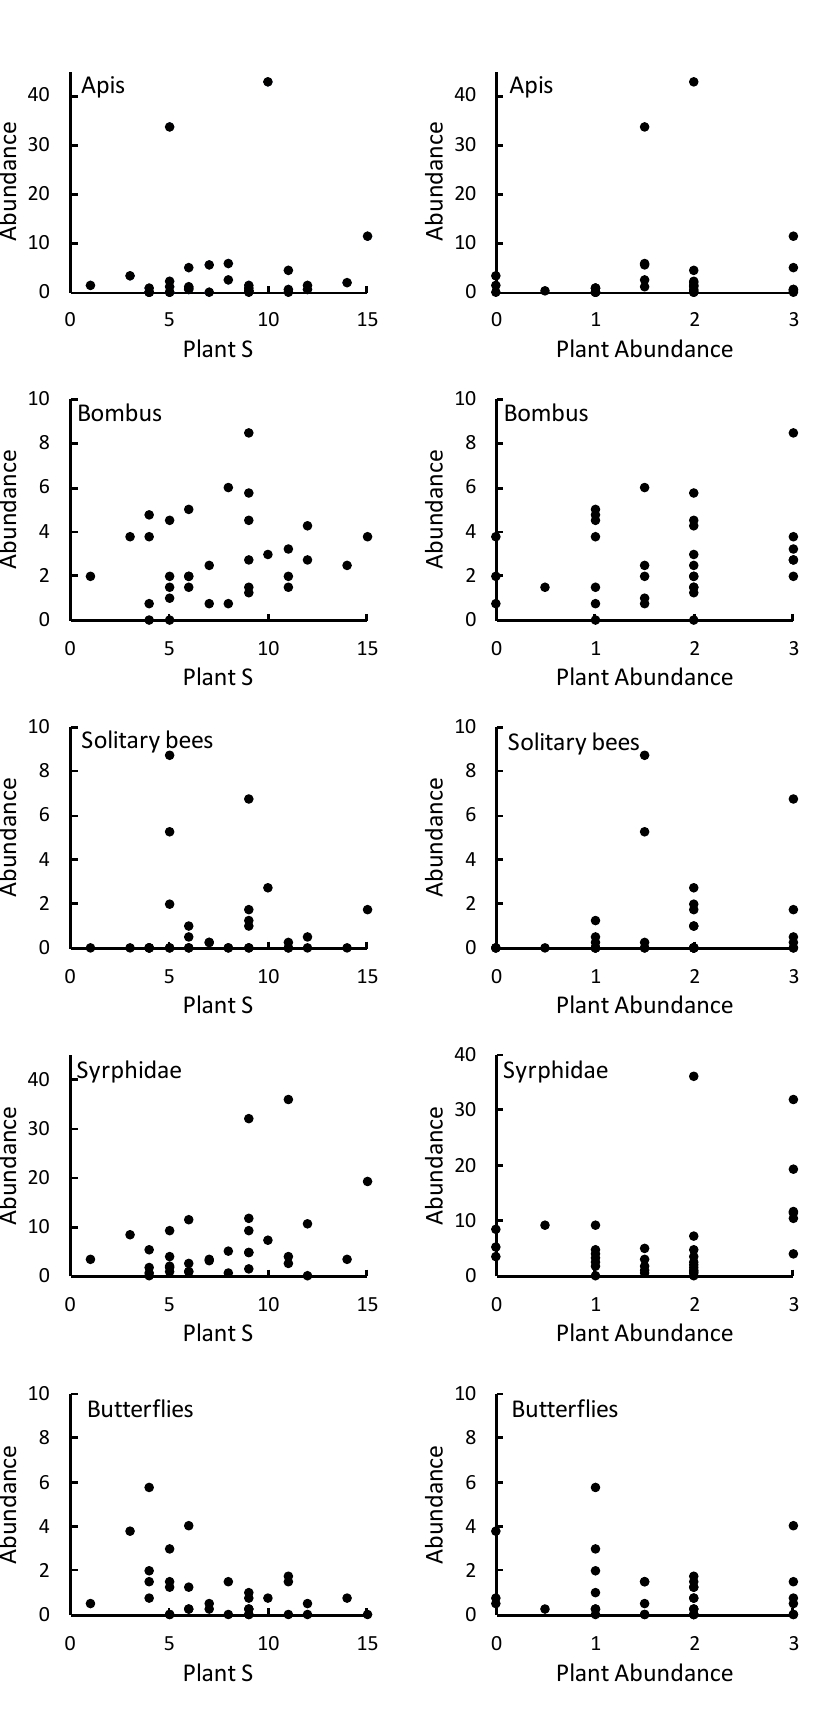
F IGURE 7. Scatterplots illustrating relationships between abundance of pollinating insects (mean counts per 10 min) with species richness and abundance (median abundance score) of field boundary flowering plants over three study